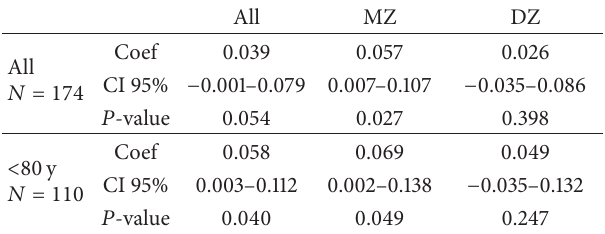
Table 4: Intrapair